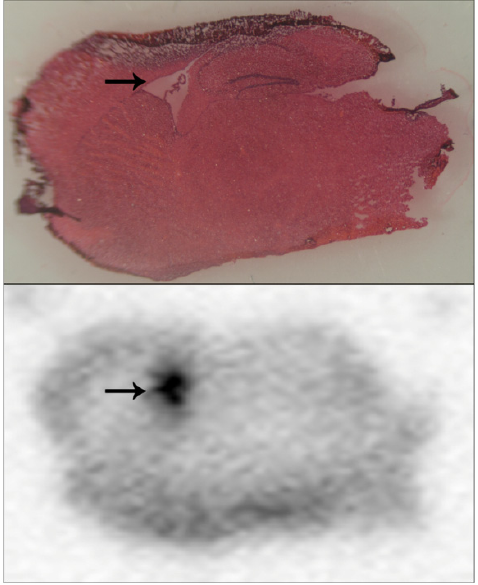
Figure 5. Pesticide radiolabel microlocalisation within brain tissue